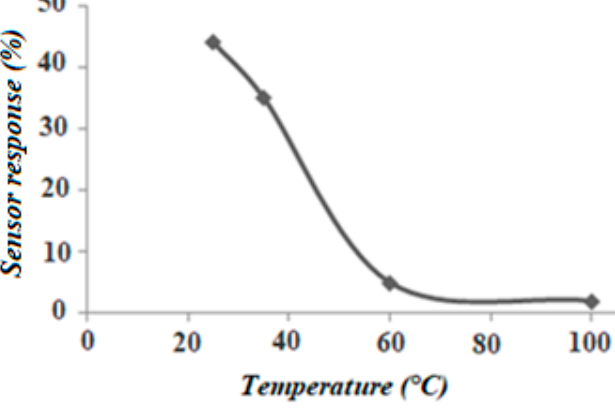
Figure 8. Sensor response to 1060 ppm of NO 2 as a function of operating temperature.